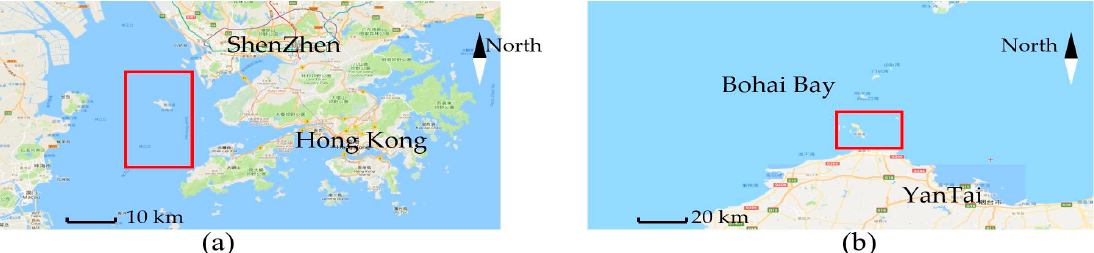
Figure 7. The surveying areas in ShenZhen and Bohai Bay. ( a ) shows the surveying area in ShenZhen. ( b ) shows the surveying area in Bohai